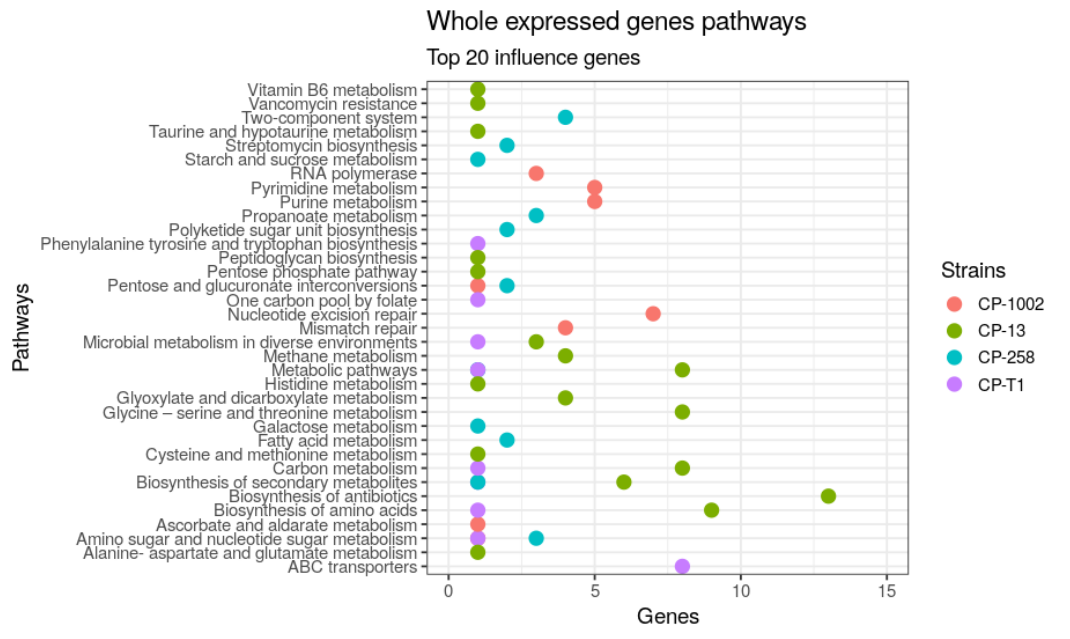
Figure 2. The pathways that involve the top 20 genes identified in the whole expressed genome network in CP-258, CP-13, CP-T1, and CP-1002.